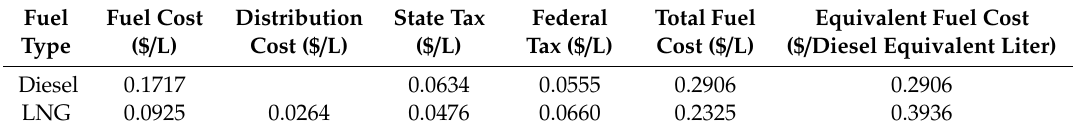
Table 1. Average LNG as well as diesel fuel cost worldwide (unit conversion) [14].